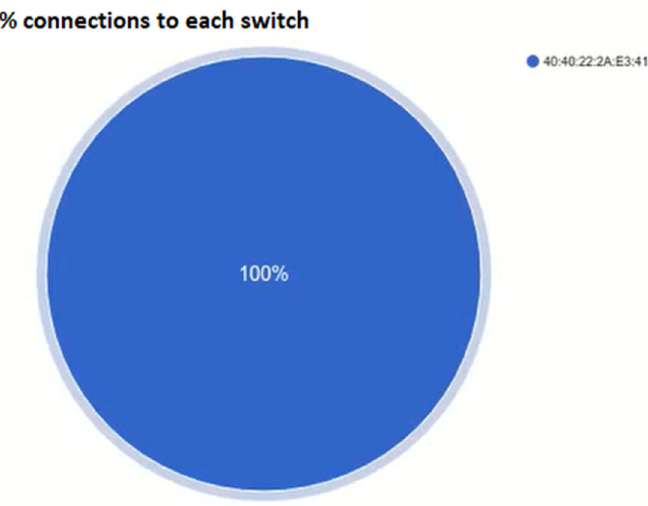
Figure 17. Connections to switches for node SW2.